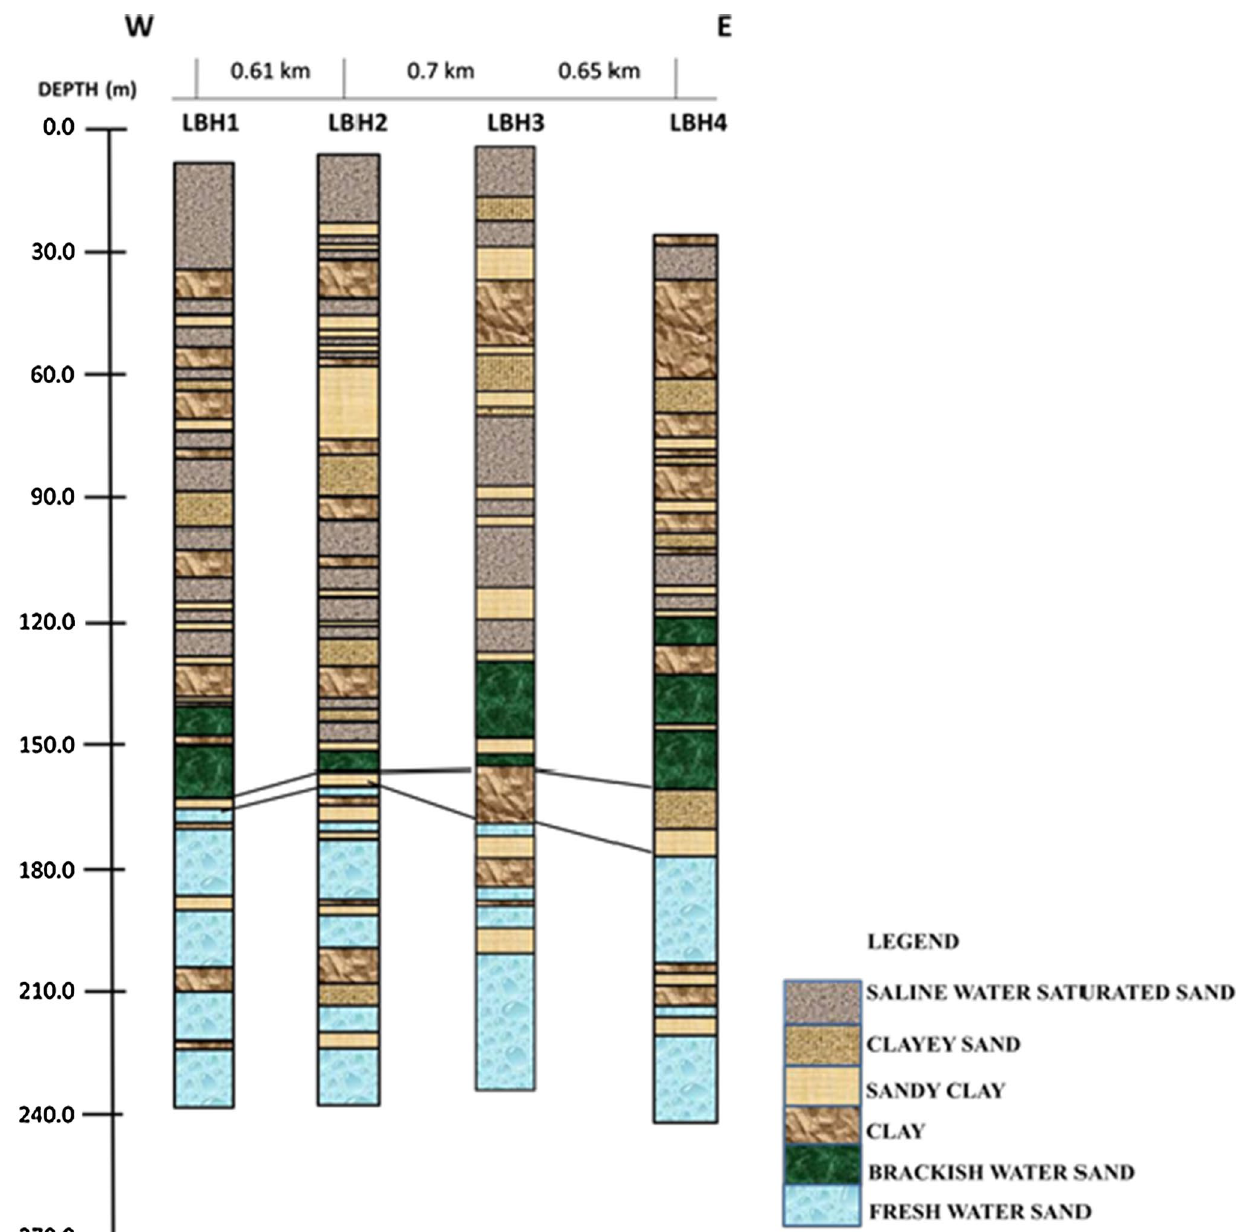
Fig. 6 Correlation panel of geosection C–C ′ showing the occurrence of the end of polluted sand unit and the beginning of freshwater sand